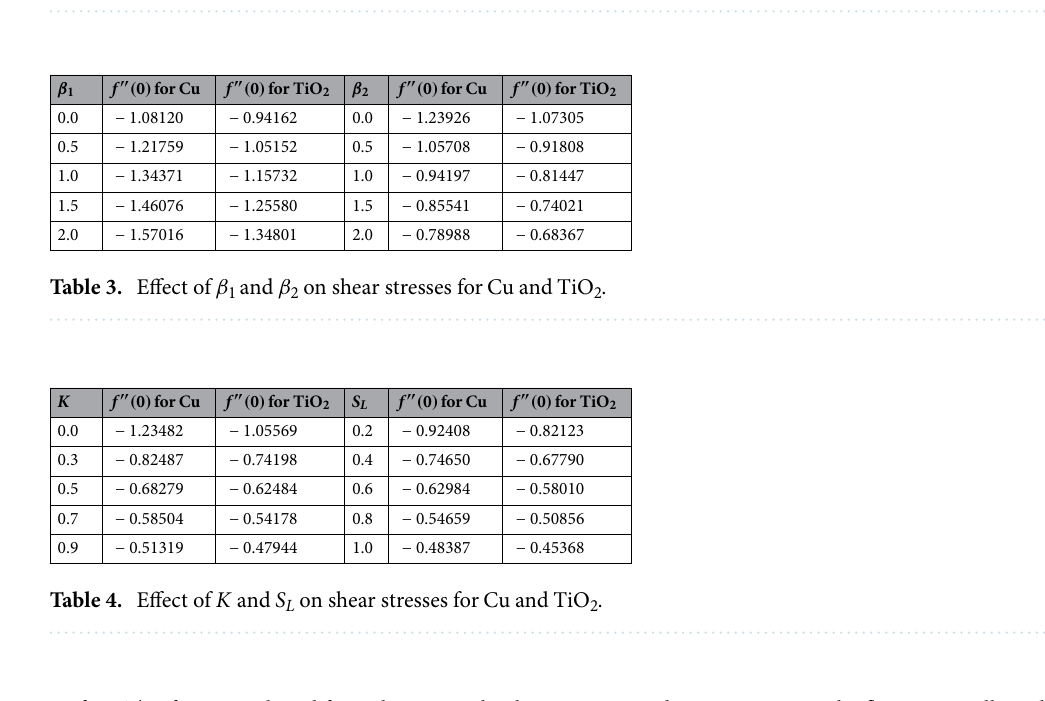
Figure 10. Temperature profile for S L .